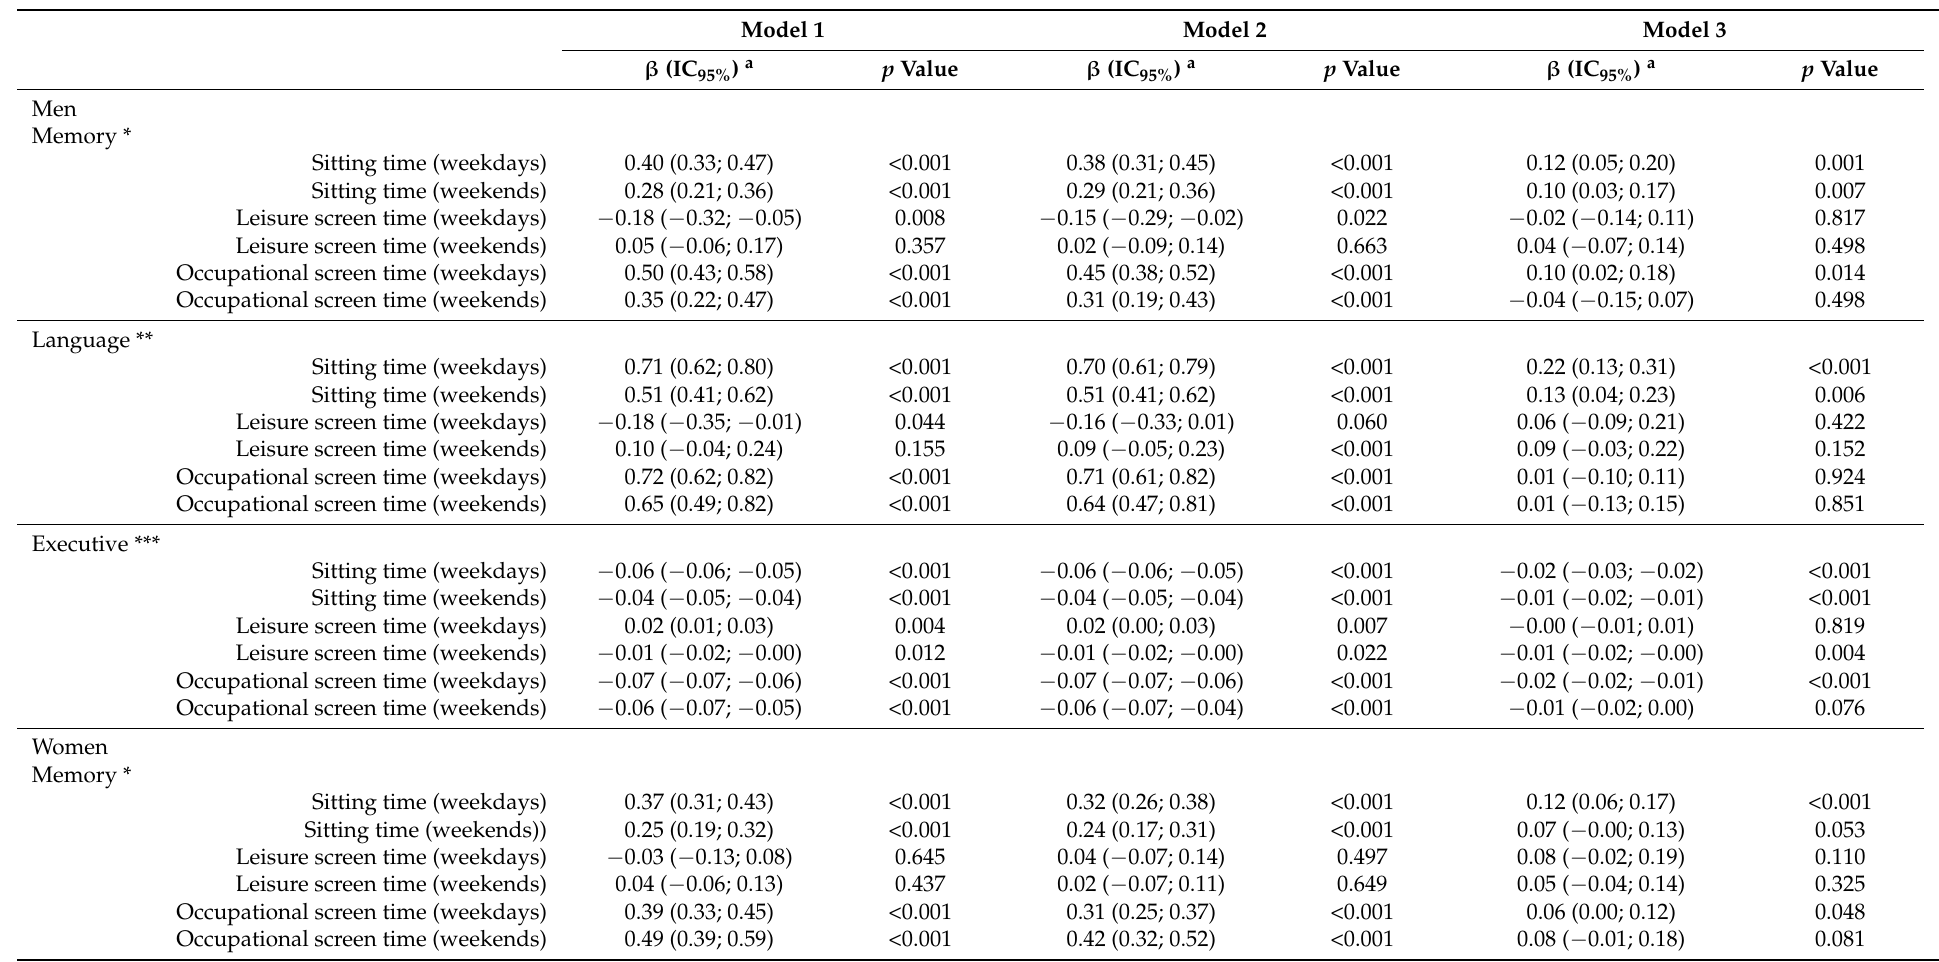
Table 2. Cross-sectional associations between types of sedentary behavior and performance on cognitive tests according to sex. ELSA-Brasil (2012–2014) (n = 6505). Model 1 Model